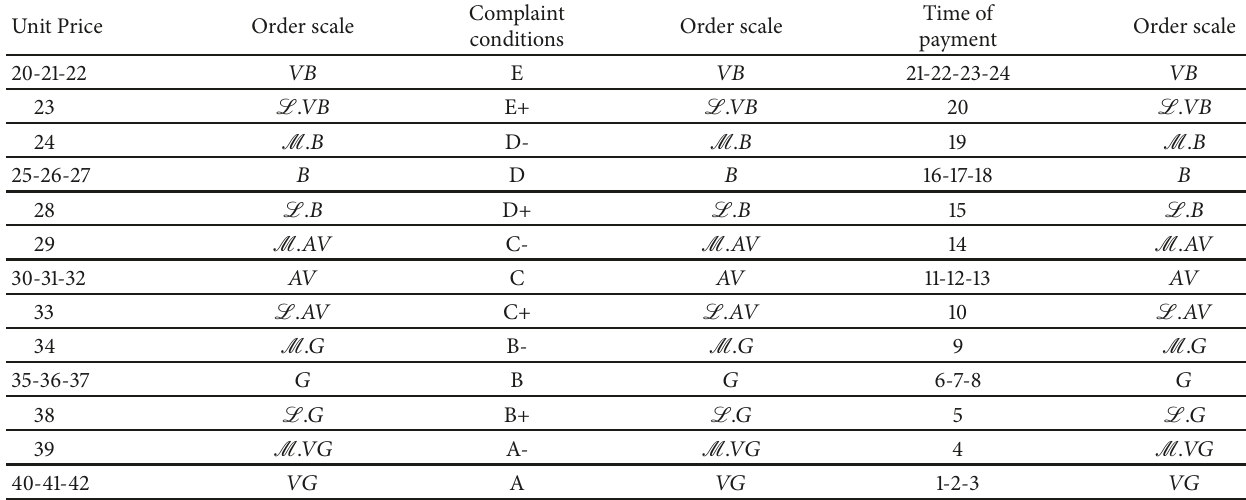
Table 2: The mechanism for Seller’ evaluating negotiation templates by linguistic order scale. Unit